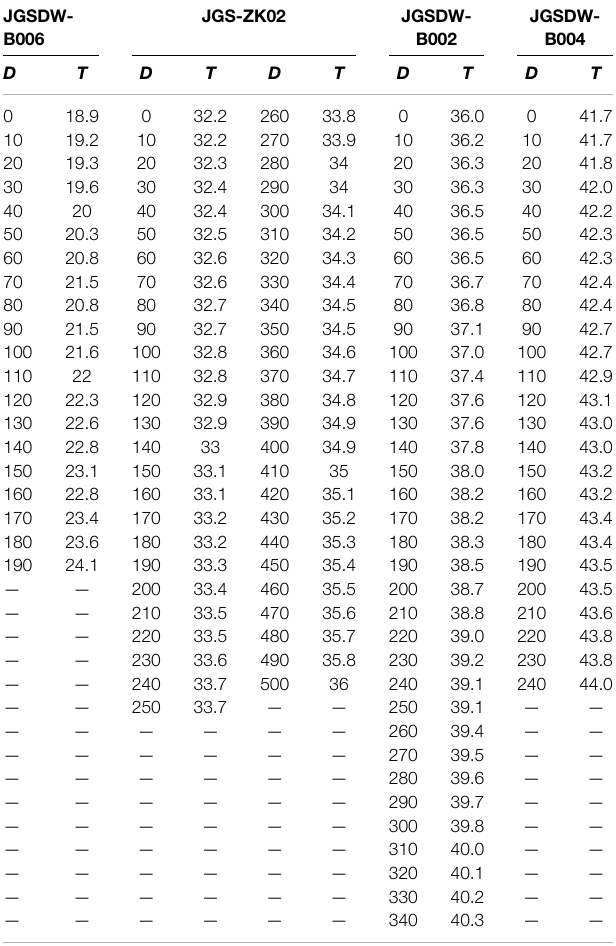
TABLE 1 | Temperature logging of geothermal wells in the study area.